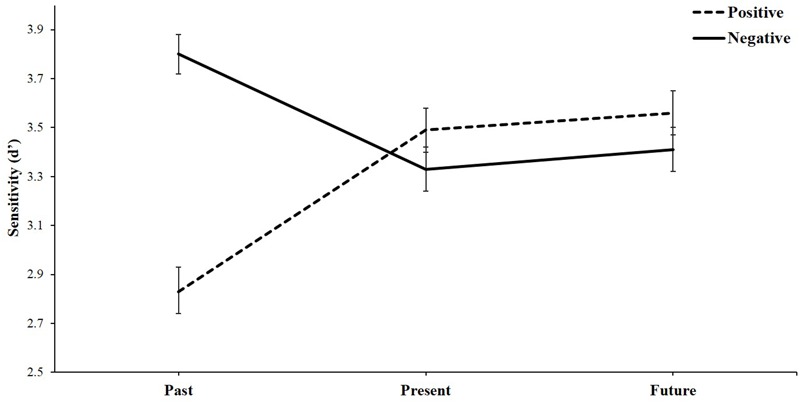
Sensitivity d’ as a function of attribute valence and temporal selves. Error bars of all figures indicate standard errors (SEs).